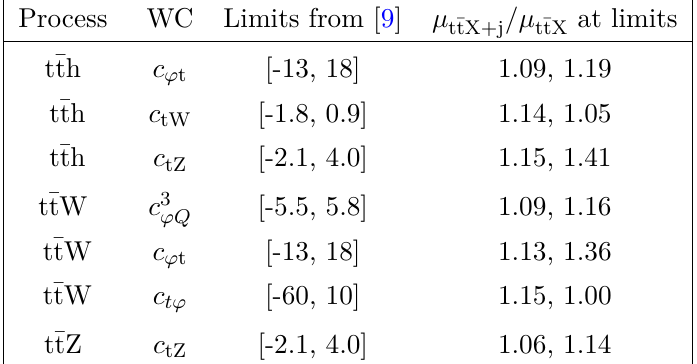
Table 3 . Comparison of µ t¯tX+j and µ t¯tX at the limits identified in [9] for t¯th , t¯tW , and t¯tZ . Wilson coefficients whose µ / µ ratio is greater than 1.10 at either the lower or upper limit t¯tX+j t¯tX are included in the